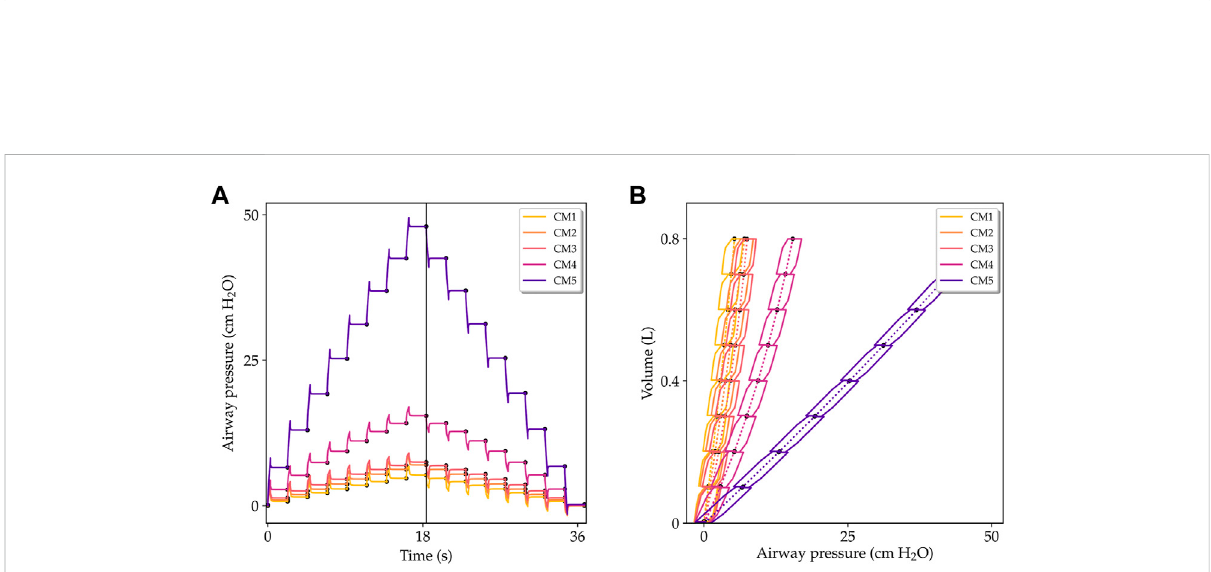
FIGURE 8 Simulation of lungs being studied with the supersyringe method. (A) Airway pressure versus time during the volume-controlled in fl ation- de fl ation protocol. (B) Pressure-volume curves for in fl ation and de fl ation processes. Solid lines show the pressure-volume evolution during the dynamic process. Dotted lines indicate the resulting quasi-static P-V curves for each constitutive model